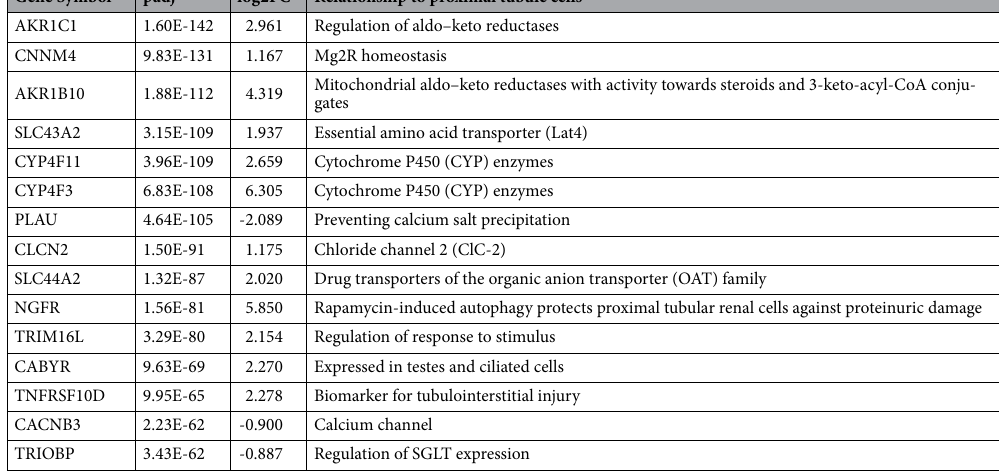
Table 1. Top significantly expressed genes involved in regulation of proximal tubule regulation.